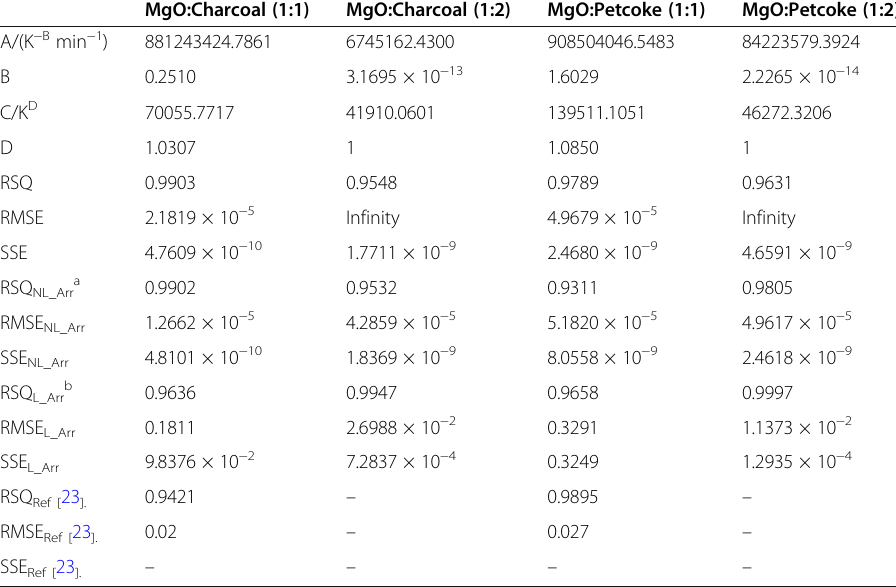
Table 4 The parameters obtained from fitting of final values of k by Eq. (8) and the relevant statistical quantities of fitting [30] for reactions of MgO with carbonic reductants in different molar ratios and at temperatures 1723.15 K, 1748.15 K, 1773.15 K, 1798.15 K, and 1823.15 K